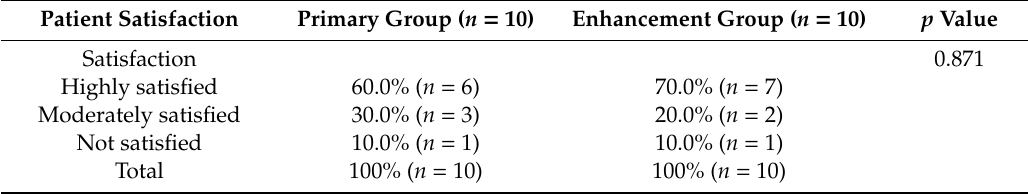
Table 4. Patient satisfaction for the topography-guided laser in situ